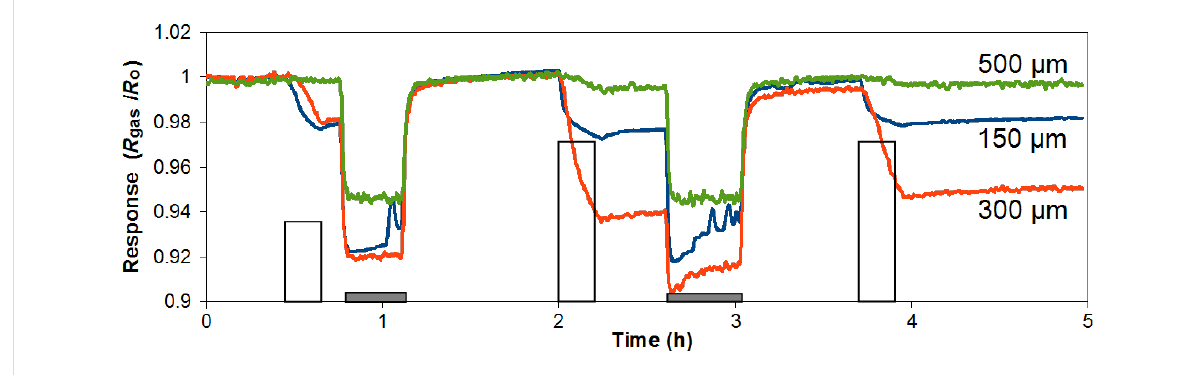
Figure 8: Room temperature detection of NO 2 for sensors with different CNT lengths. White pulses indicate the exposure to 0.5 ppm, 1 ppm and 1 ppm of nitrogen dioxide (duration was 15 min). Grey bars indicate the periods of heating at 150 °C that help clean the surface of CNT after being exposed to nitrogen dioxide. Heating is not applied after the last exposure cycle and baseline is not regained.